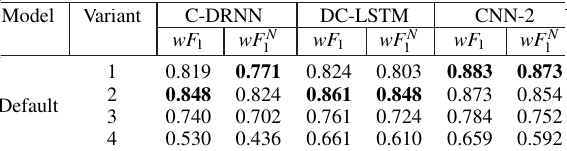
TTaable 6. WWeeighted F 1 def-score of faault model with all input